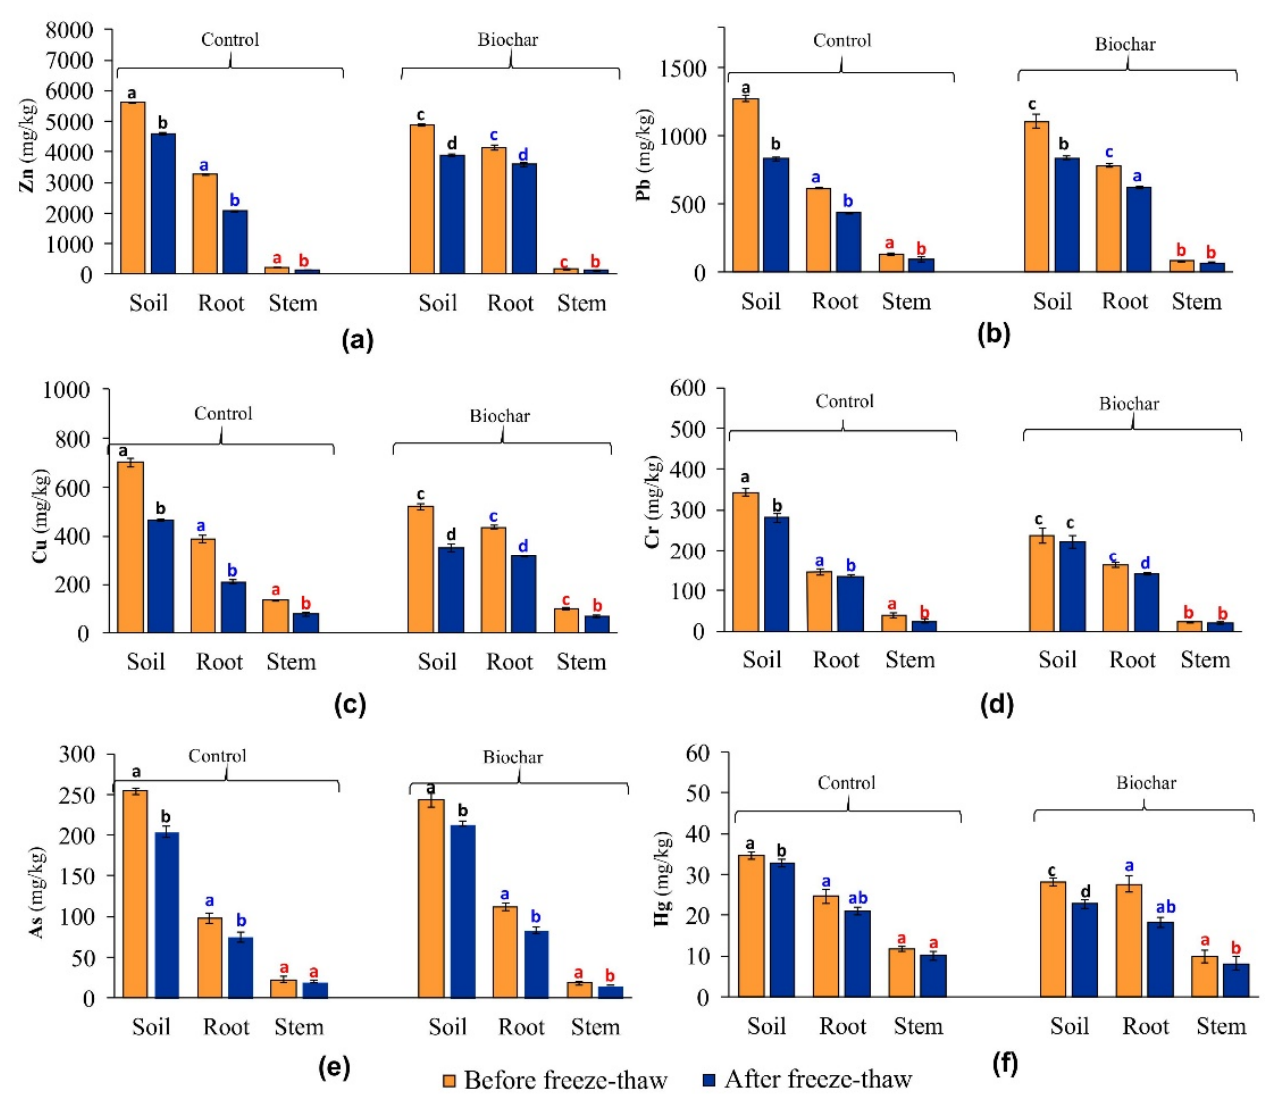
Figure 2. Effect of biochar amendment on distribution of selected metals/metalloids between soil and roots and stems of Lolium perenne L. before and after freeze–thaw treatment. The letters from ( a – f ) indicate the reading order of potentially toxic elements. Phytostabilization of the metal/metalloid-contaminated soil was as described in Materials and Methods. Data are mean ± standard deviation ( n = 3). Different color letters: black for soil, blue for roots, and red for stems, indicate significant differences ( p < 0.05).